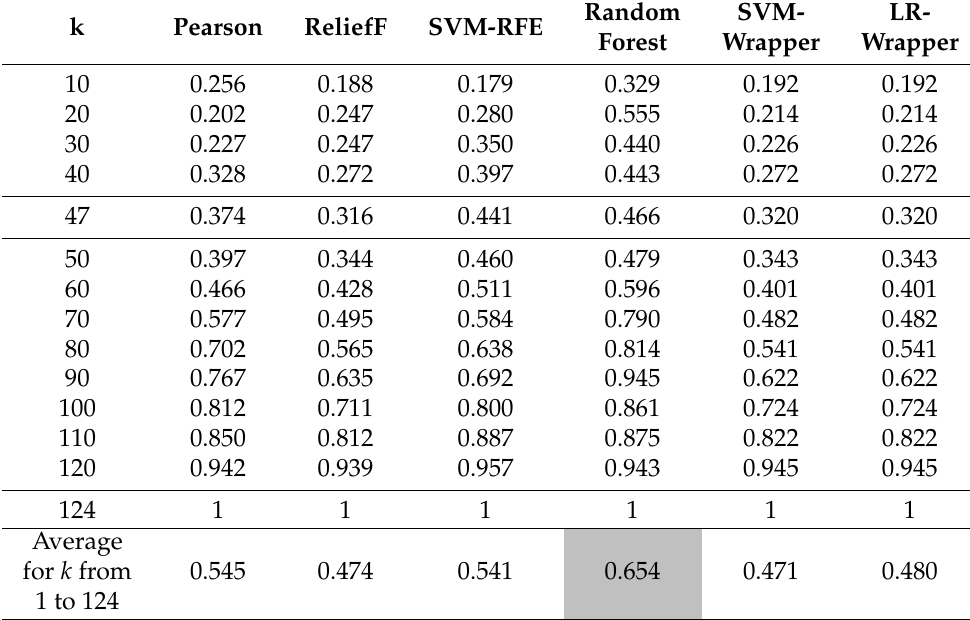
Table 8. Stability of a set with 7 top-k lists assessed through average pairwise similarities with the Jaccard index for different values of k . In gray background the best